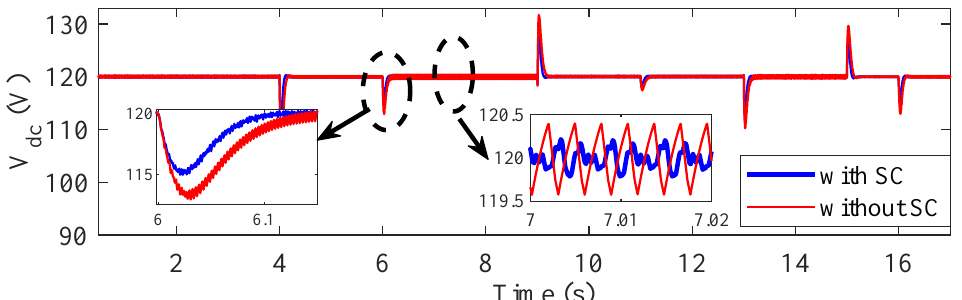
Figure 7. Common DC-bus voltage under varying output power from the PV unit and changing load conditions with step changes in the solar